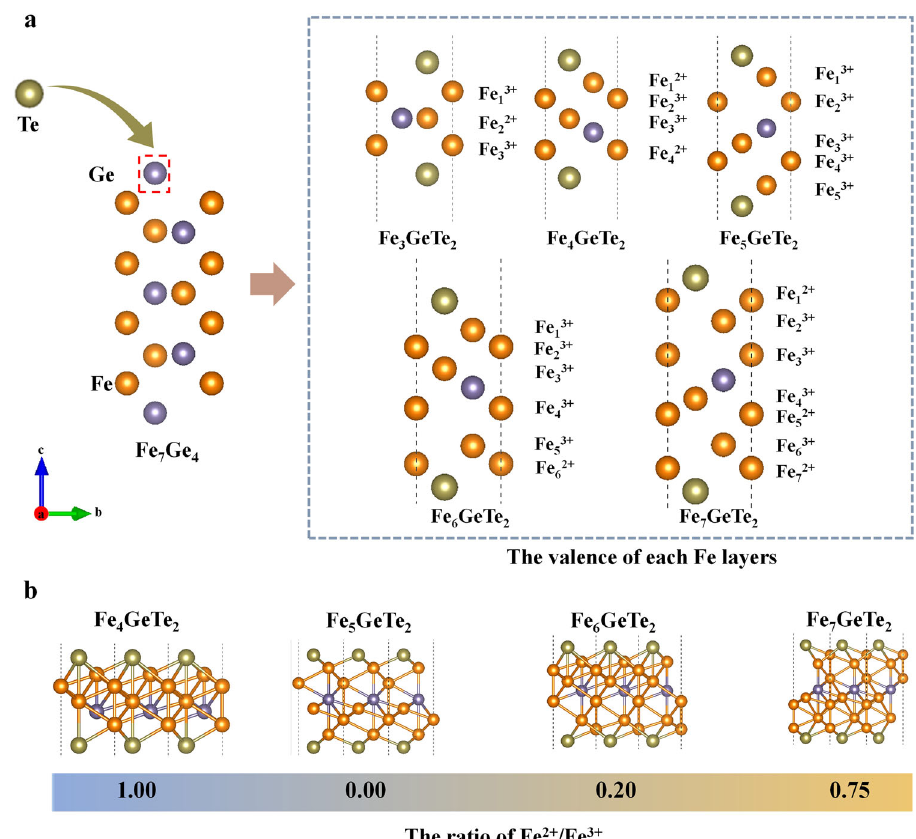
Fig. 1 Crystal structure of Fe n GeTe 2 (4 ≤ n ≤ 7). a Schematic illustration of Te-substituted Fe 7 Ge 4 crystal and of fi ve structures in the series Fe n GeTe 2 . The green, purple and gold spheres correspond to Te, Ge, and Fe atoms, respectively. b Stacked plane views along the [001] direction of Fe n GeTe 2 multilayer fi lms with different Fe 2 + /Fe 3 +